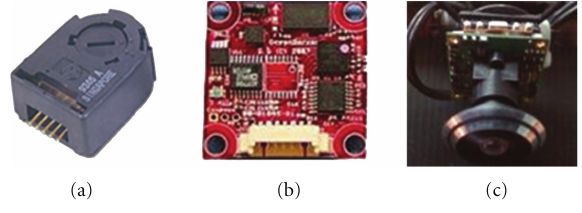
Figure 4: The encoder shown in (a) is used to measure the linear velocity and simulate the acceleration for the robot. The electrical compass shown in (b) is applied to measure the angular velocity of the robot. As shown in (c), the camera with wide angle lens is the additional measurement sensor. The three sensors are combined to estimate the localization of targets.